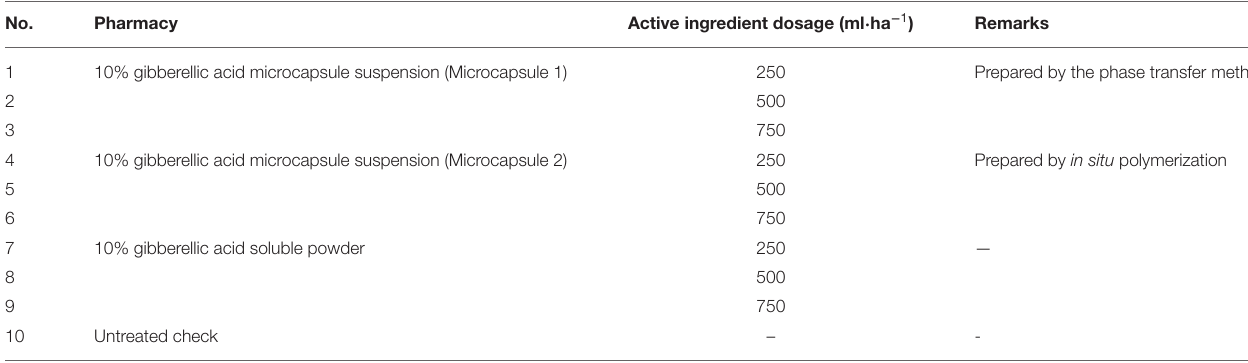
TABLE 1 | Concentration of the reagents used in the test field.